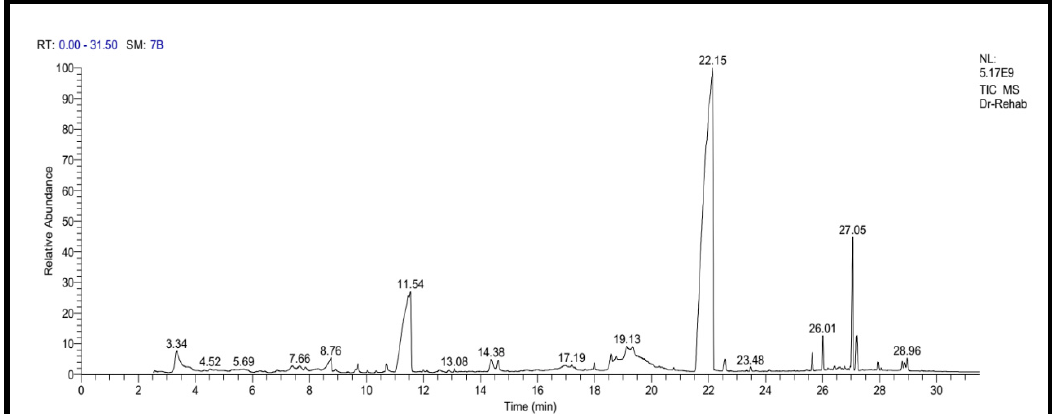
Figure 1. GC-MS analysis of KFB.